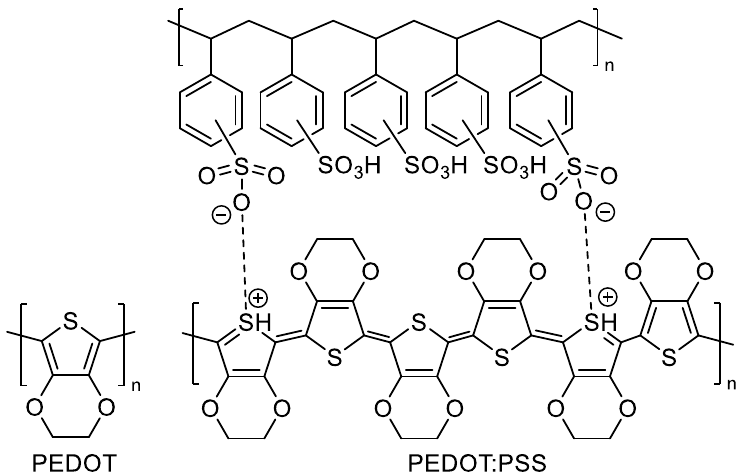
Figure 5. Left : Structure of poly(3,4-ethylenedioxythiophene (PEDOT); Right : structure of PE- DOT:PSS.